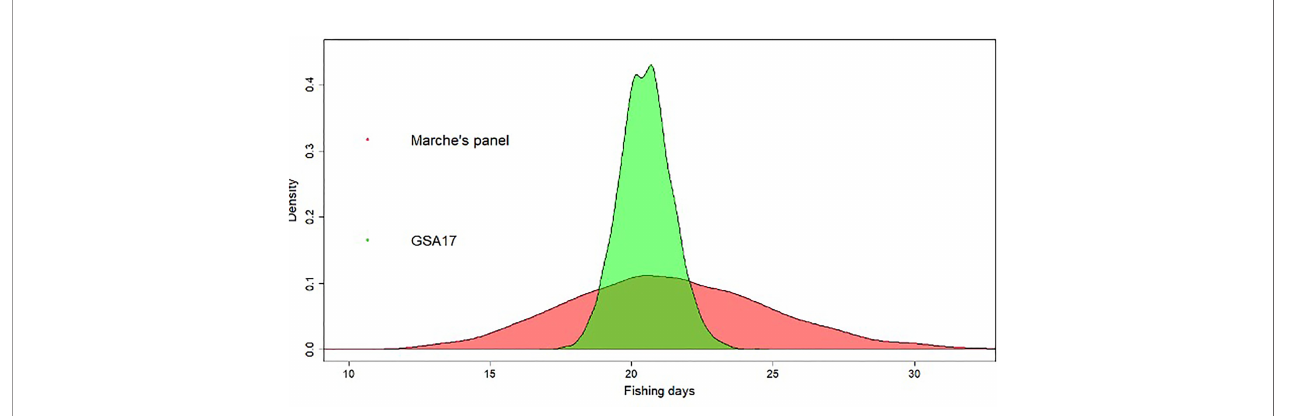
FIGURE 4 | Distributions obtained from 10000 random draws of the bootstrap algorithm: the green shaded area represents the distribution of the mean of annual fi shing days for the probabilistic sample of the GSA17 area, while the red shaded area represents the same statistic for the Marche ’ s